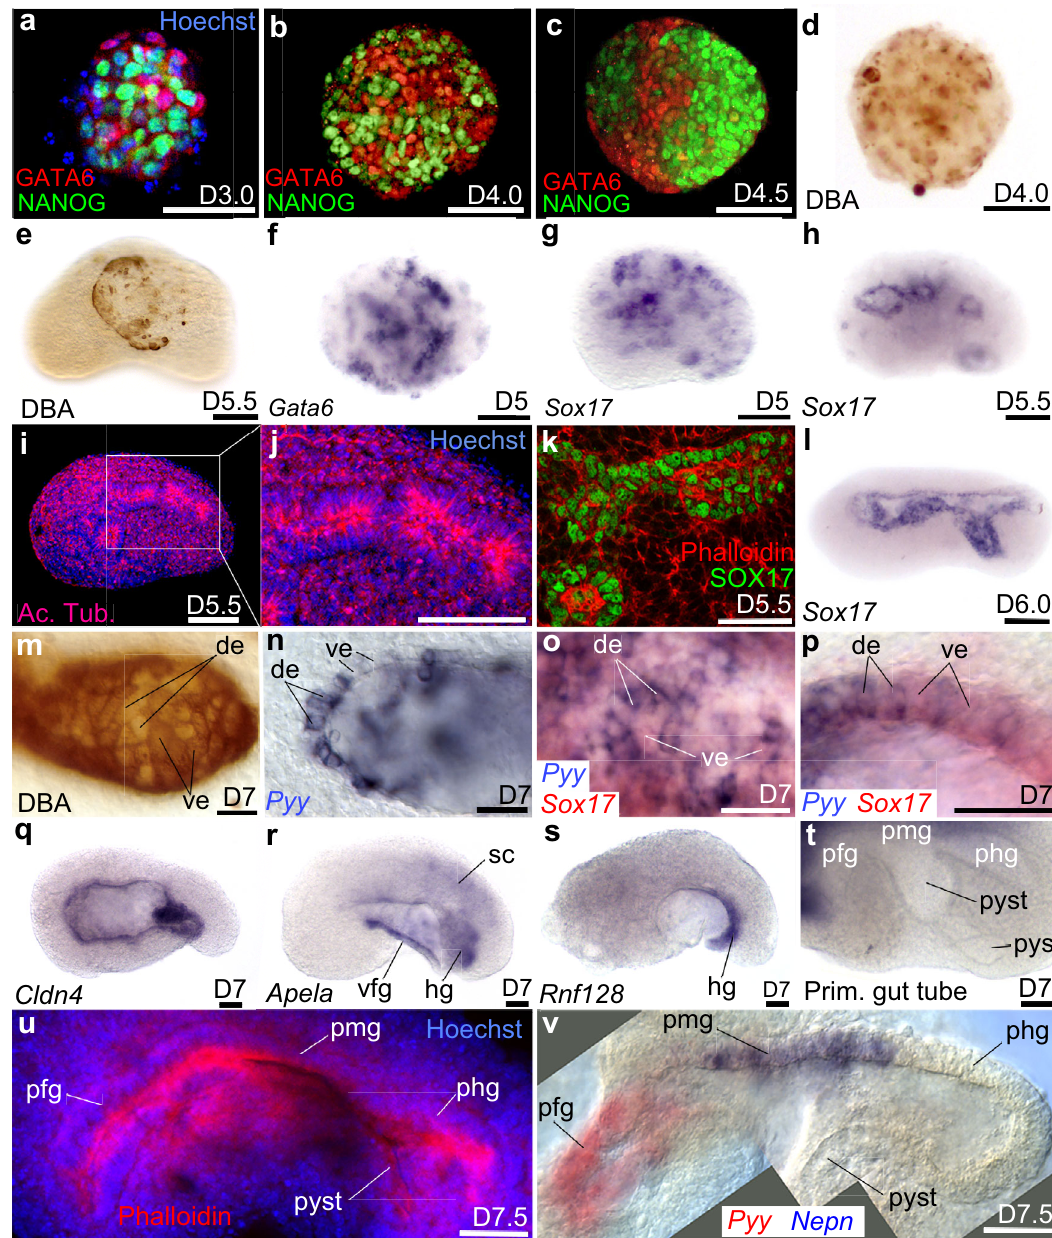
Fig. 3 Endoderm germ layer and formation of the embryoid gut tube. a – c Immunodetection of NANOG and GATA6 from D3.0 to D4.5. d , e DBA labelling of visceral endoderm (ve) at d D4.0 and e at the surface of the embryoid at D5.5. f , g Clumps of endoderm cells expressing f Gata6 or g Sox17 . At